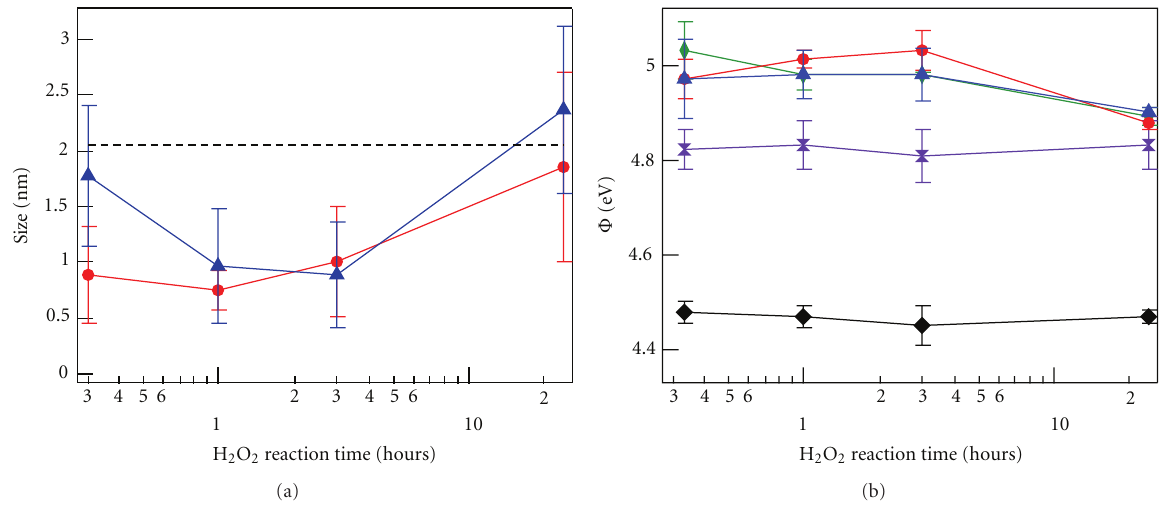
Figure 2: E ff ect of chemical oxidation with H 2 O 2 on MoO x nanoparticle properties. (a) Dependence of nanoparticle size on chemical oxidation time (up to 24 hrs), showing that compared to as-synthesized nanoparticles (dashed line), both 0.1 M H 2 O 2 (blue) and 0.3 M caused npMoO x size to decrease to 1nm (up to 3 hrs) and then increase back to 2nm (24hr). (b) Dependence of nanoparticle film Φ versus chemical oxidation conditions, showing Φ of as-synthesized npMoO x (black) was increased from 4.48 eV to 4.85 eV with 0.05 M H 2 O 2 (purple) and that the increase was independent of the reaction time between 20 min and 24 hr. In contrast, 0.1 M (blue), 0.2M (green), and 0.3M (red) H 2 O 2 , all caused work function to increase to 5.0eV with a reaction time of up to 3hr. However, a further increase in reaction time to 24 hrs decreased Φ to 4.9